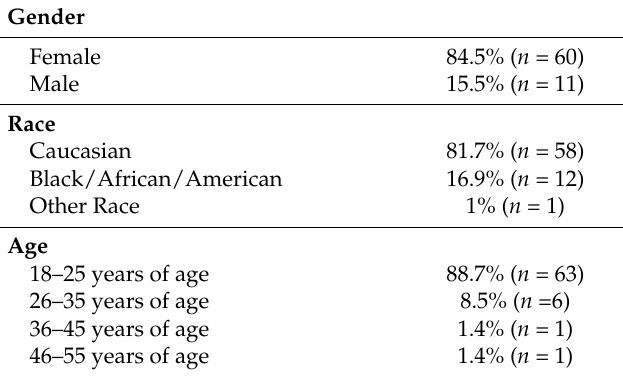
Table 2. Demographic characteristics of